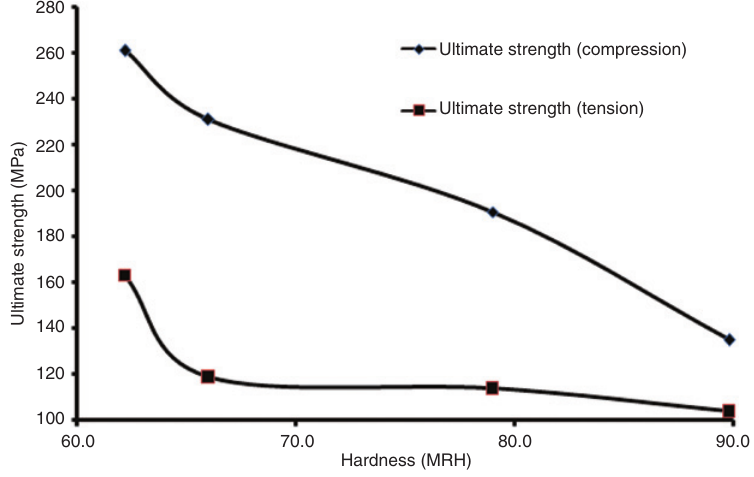
Figure 7 Variation of ultimate strength with hardness (MRH).